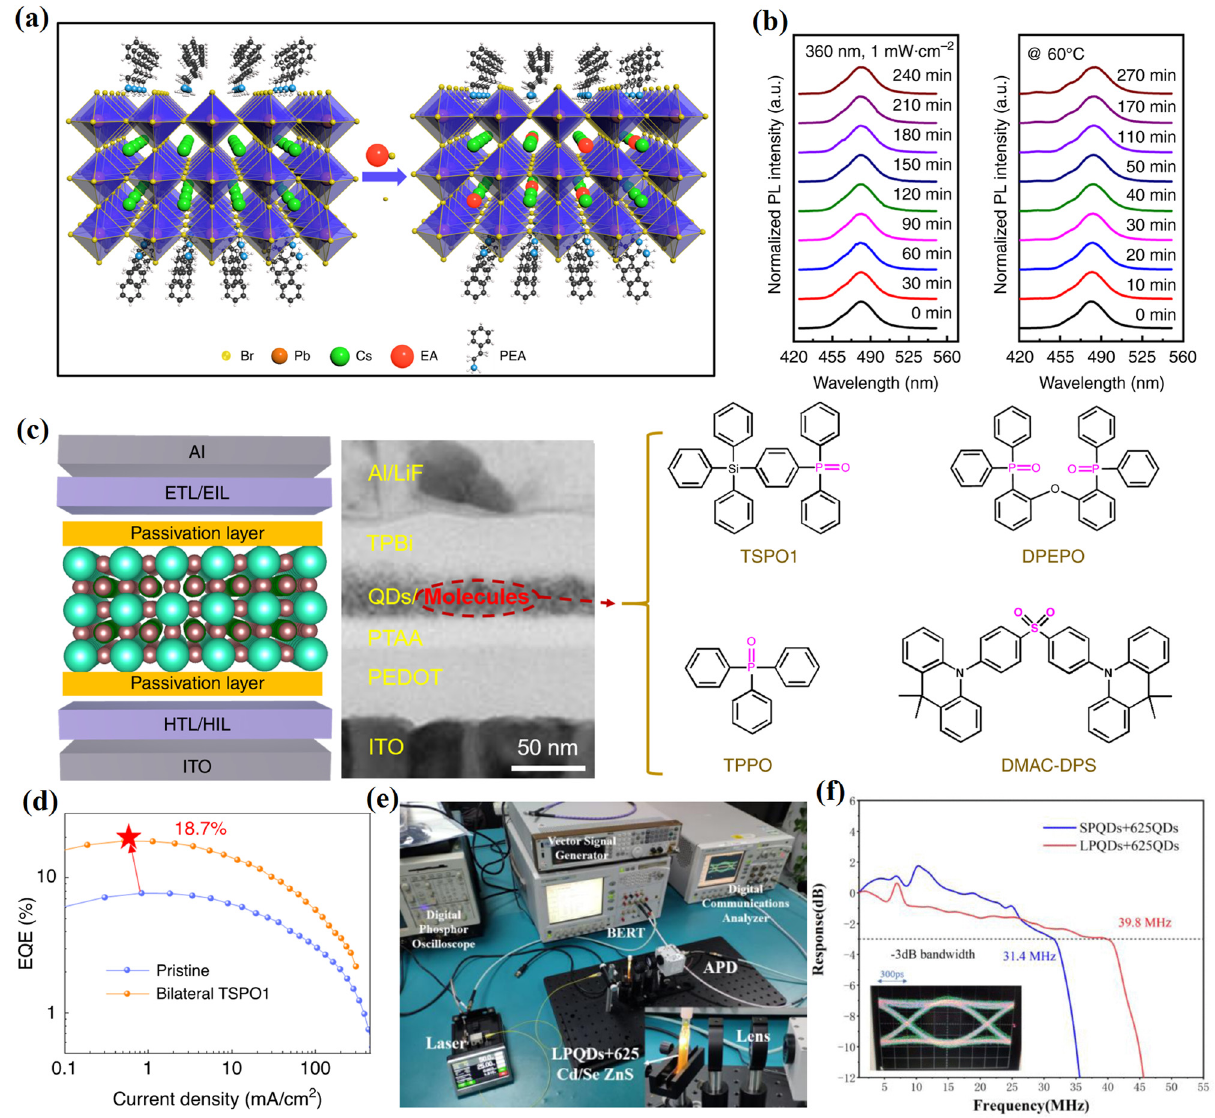
Figure 10: ( a ) Structure diagram of EA cation in perovskite lattice replacing Cs + in quasi - 2D perovskite. ( b ) Normalized PL spectrum of quasi - 2D perovskite fi lm with 60% EABr content after continuous UV radiation and continuous heat treatment. Reproduced with permission from ref. [ 63 ] . Copyright 2020, The Authors, published by Springer Nature. ( c ) The device structure diagram and cross - sectional TEM image of the bilateral passivation, the passivation molecules are TSPO1, DPEPO, TPPO, and DMAC - DPS, respectively. ( d ) EQE of the pristine and bilateral - passivated devices. Reproduced with permission from ref. [ 9 ] . Copyright 2020, The Authors, published by Springer Nature. ( e ) VLC system based on LD. ( f ) Bandwidth measurement of white light illumination system based on LD. Reproduced with permission from ref. [ 22 ] . Copyright 2019,